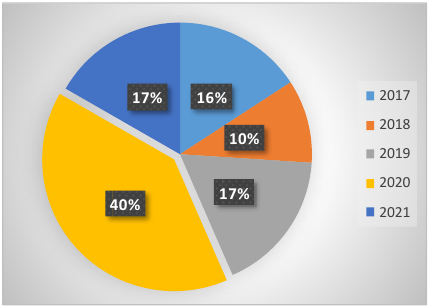
Figure 4: Shows the extent and the coverage location of E. crassipes in Lake Victoria in January of 2019.